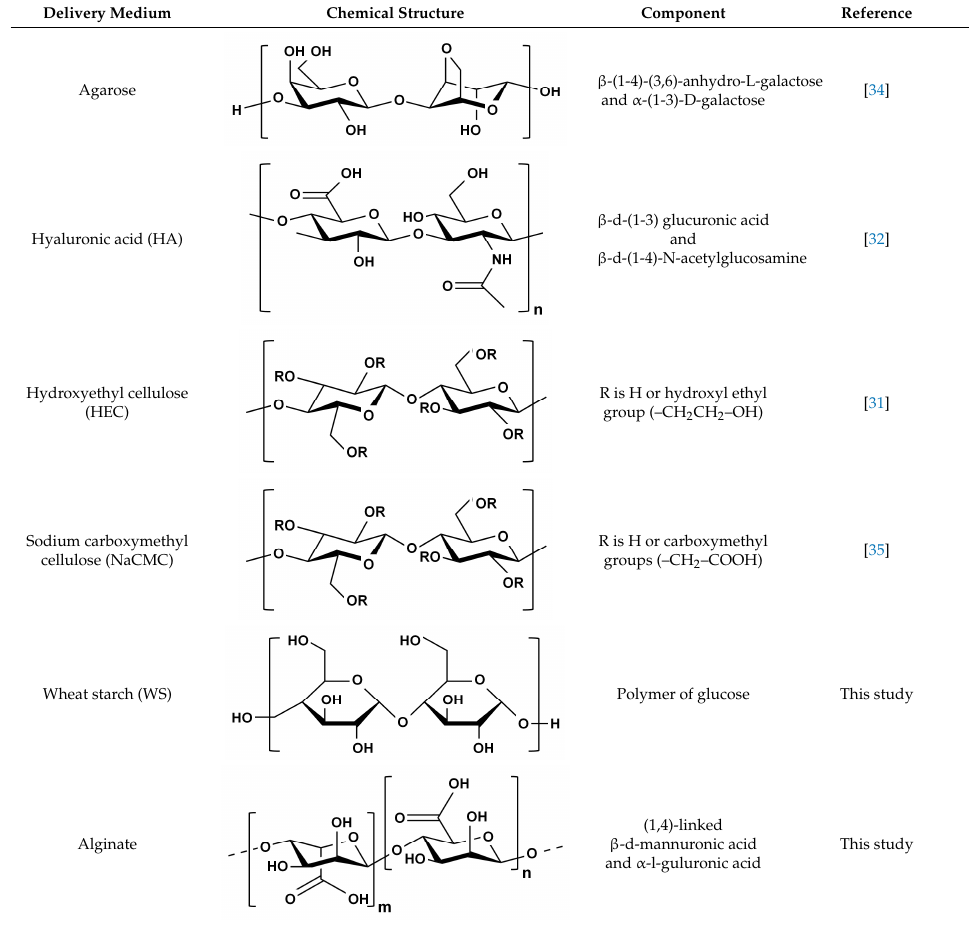
Table 2. Chemical structure of the polysaccharide-based viscous delivery media.